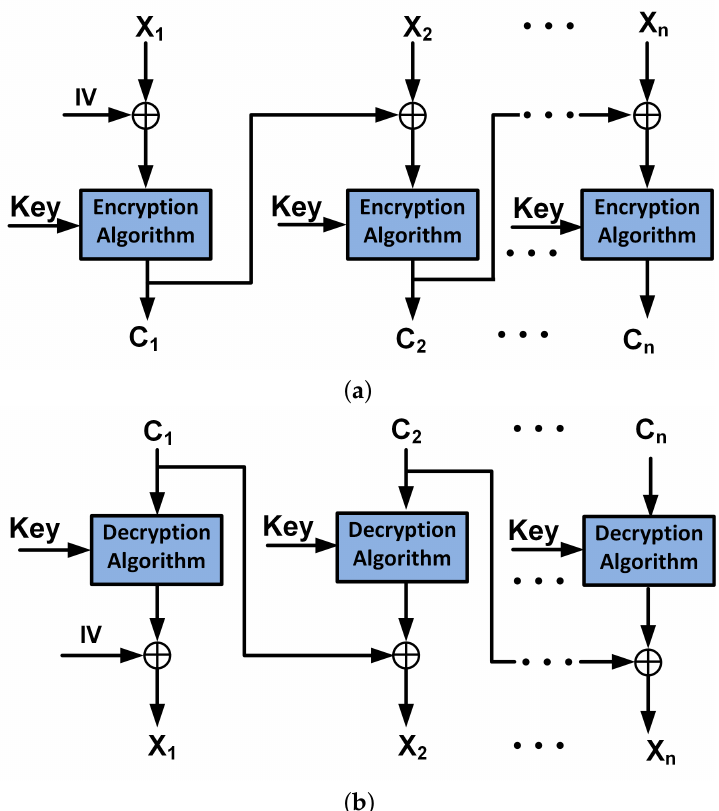
Figure 1. ( a ) CBC mode encryption, ( b ) CBC mode